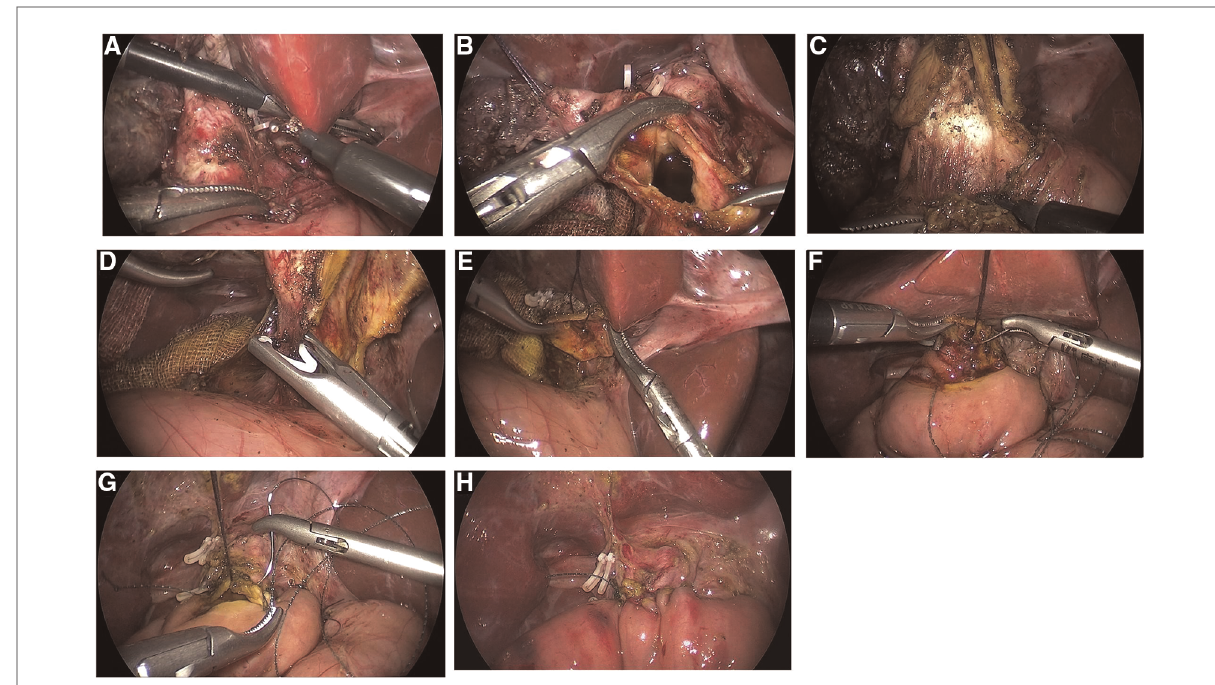
FIGURE 1 Images depicting the steps in total choledochal cyst resection and hepaticojejunostomy with Roux-en-Y anastomosis under laparoscopic guidance; the choledochal cyst was dissociated and exposed. ( A ) The choledochal cyst was dissociated and exposed. ( B ) Transverse incision of the anterior wall of the cyst was performed below the cystic duct opening, and the area was examined for vagal bile duct openings. ( C ) The cyst wall was gradually dissociated from the proximal end to the distal end. ( D ) The distal cyst wall was dissociated up to the thinner part close to the pancreatic duct, which was clamped and severed with the Hem-o-lock clip. ( E ) The opening of the common hepatic duct was trimmed. ( F ) The posterior wall of the common hepatic duct and the jejunum were sutured continuously from left to right (3 – 9 o ’ clock). ( G ) The anterior wall of the common hepatic duct and the jejunum were sutured continuously from left to right (3 – 9 o ’ clock). ( H ) Hepaticojejunostomy anastomosis was